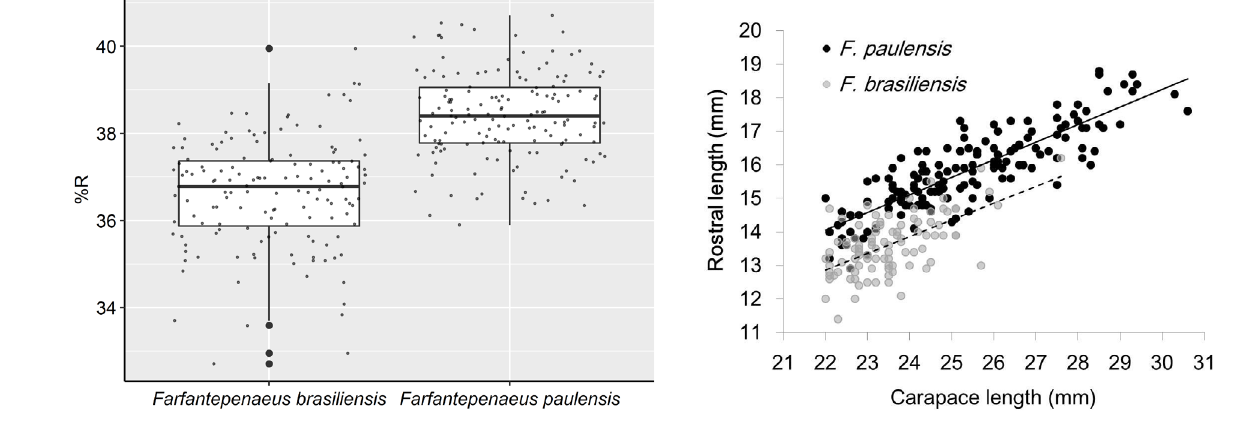
Table 1. Estimated parameters of the relationship between rostral length and carapace length for Farfantepenaeus brasiliensis and F. paulensis caught in April 2019 in the Rocha lagoon. Intercept (α), slope (β), limits of the 95% confidence intervals of α and β (± IC95%), and coefficient of determination ( R 2 ) of the model. Species N